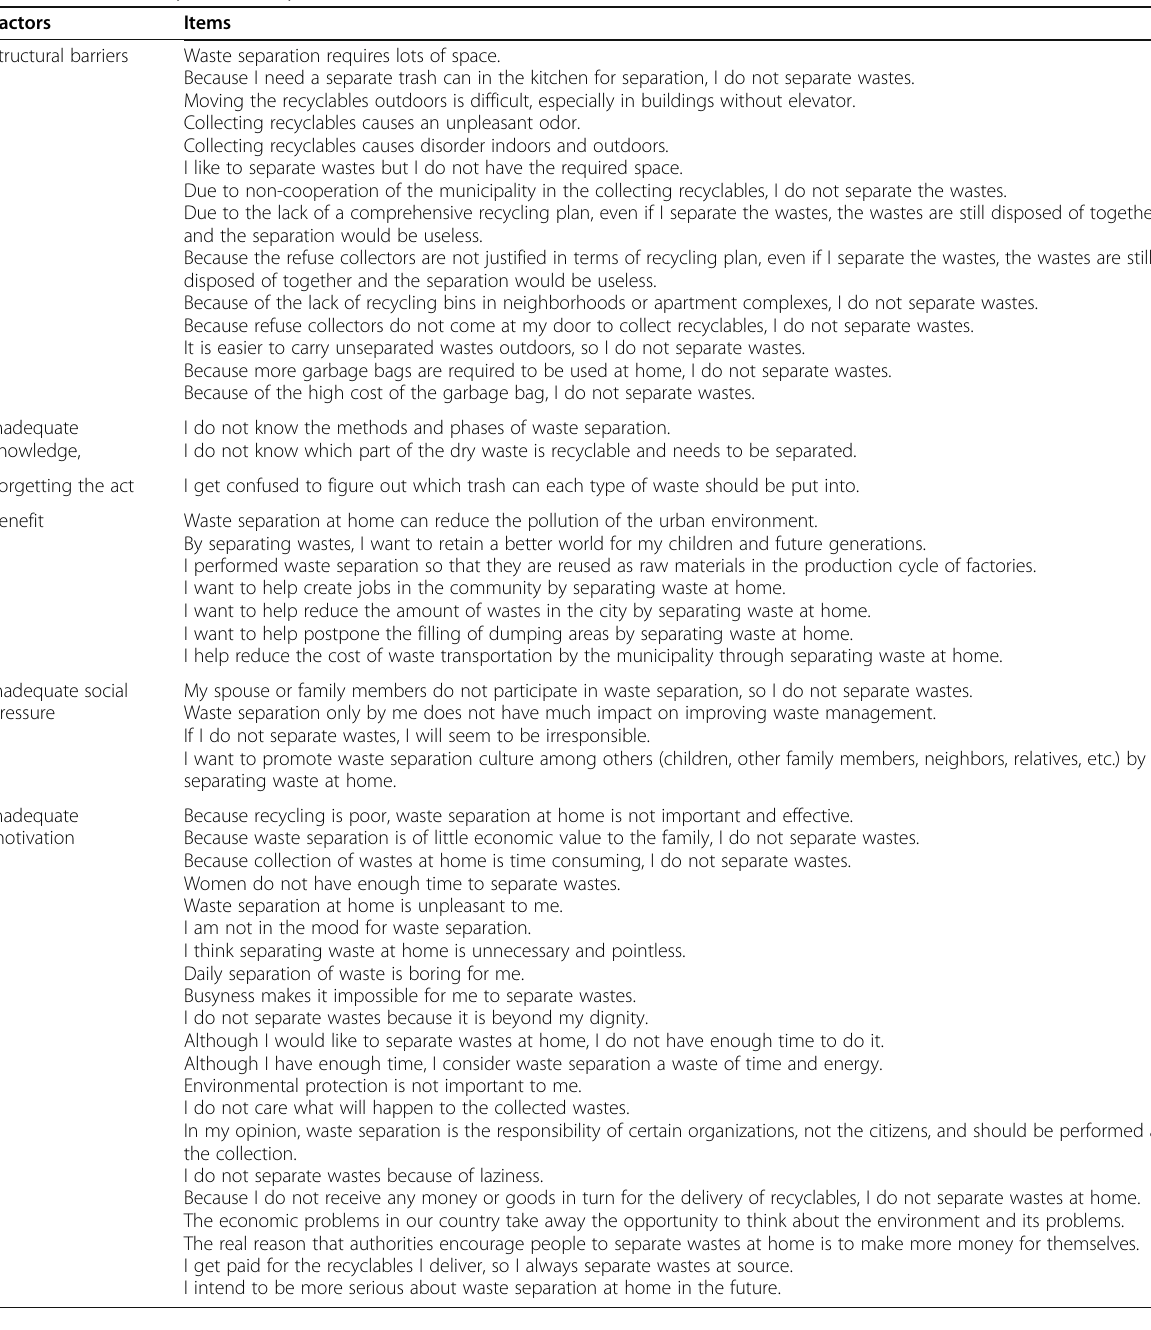
Table 3 Confirmatory factor analysis results